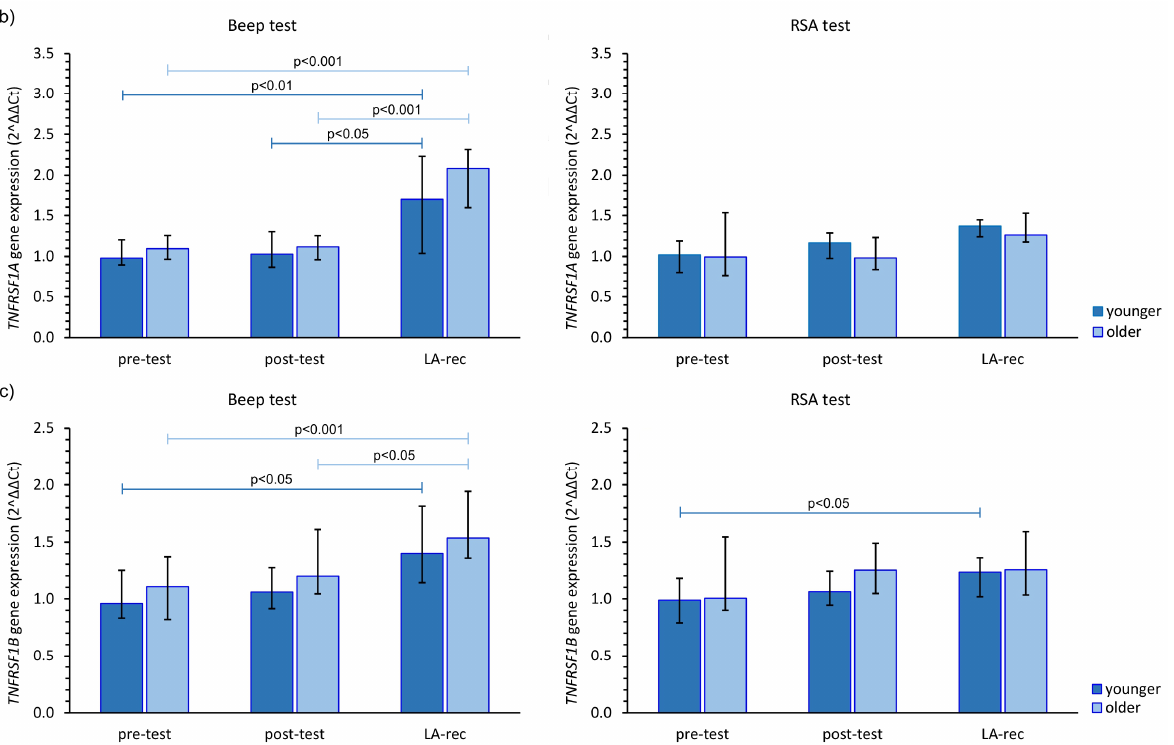
Figure 5. The impact of aerobic (Beep test) and anaerobic (RSA test) effort on the relative expression of studied genes encoding ( a ) IFNGR1 , ( b ) TNFRSF1A , ( c ) TNFRSF1B . The figures present median (interquartile range) values. Significance levels of differences observed between analyzed time points (pre-test vs. post-test vs. LA-rec) were assessed using Friedman’s analysis of variance for repeated measures followed by post hoc Dunn’s test with Bonferroni